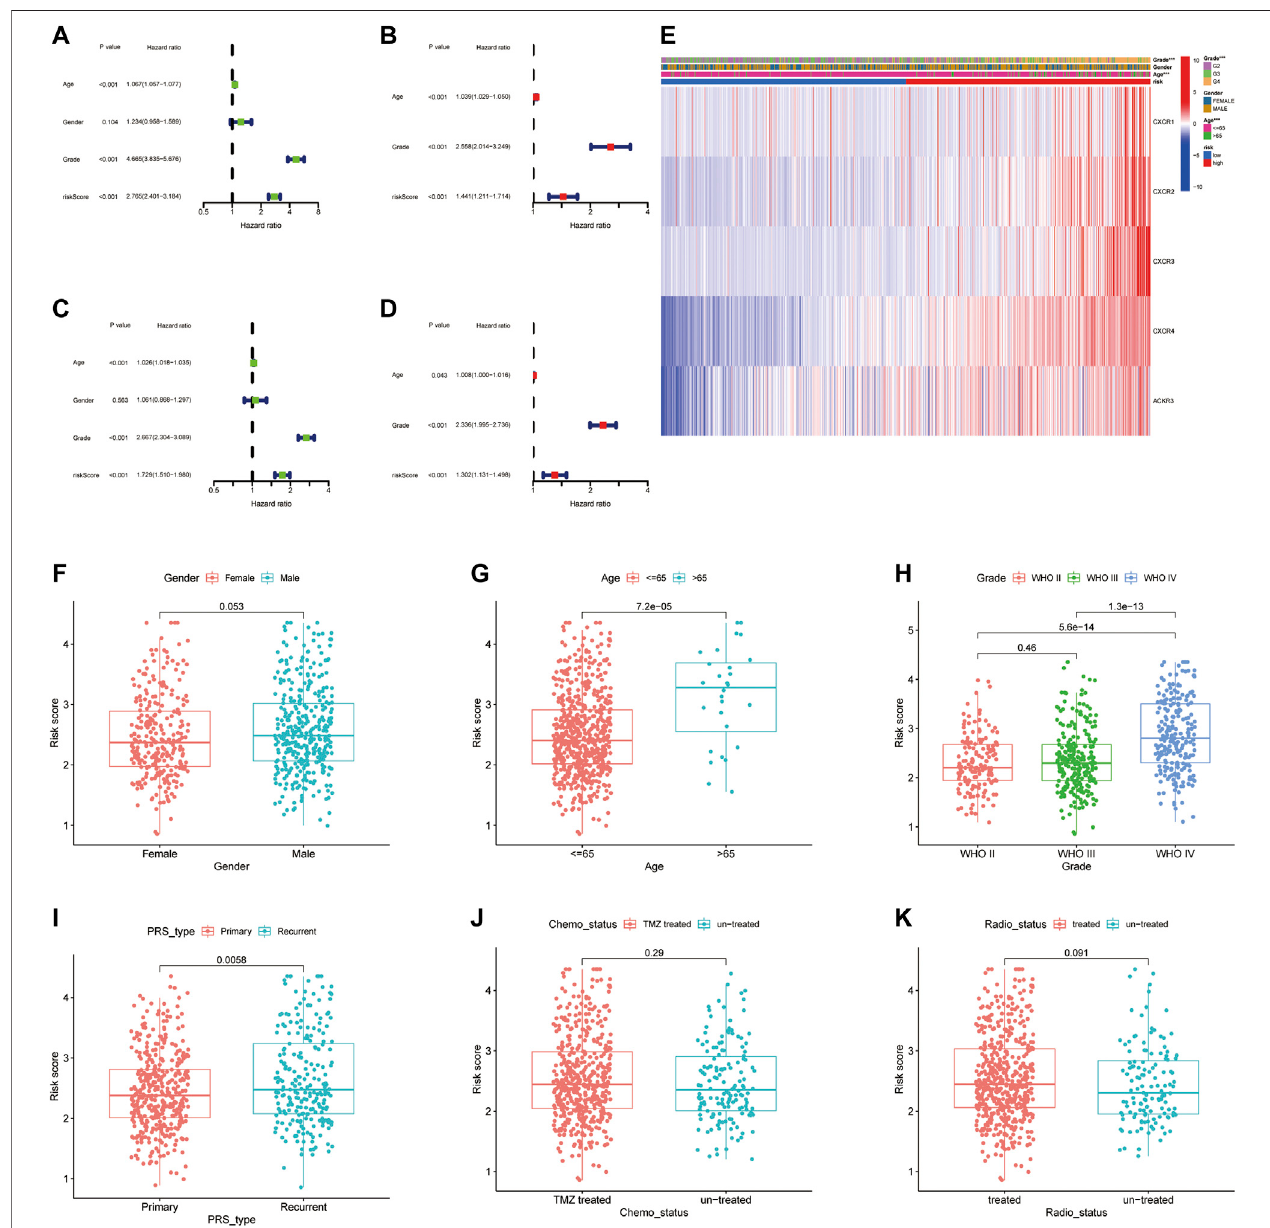
FIGURE 5 | Independent prognostic analysis of CR-Score and clinicopathological parameters. Forrest plot of univariate ( A , Green) and multivariate ( B , Red) Cox regression analysis in the TCGA cohort. Univariate (C) and multivariate (D) Cox regression analysis in the CGGA cohort. (E) The relationship between CR-Score and clinicopathologic indicators. (F – K) Combination of CR-Score with gender, age, grade, primary/recurrent status, chemotherapy status, radiation therapy.